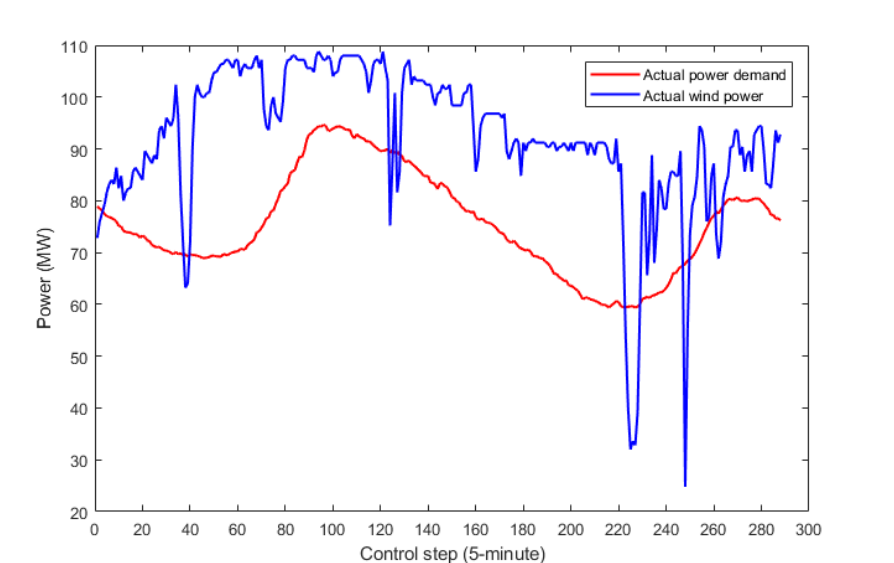
Figure 6. Actual renewable power and power demand (lower demand).